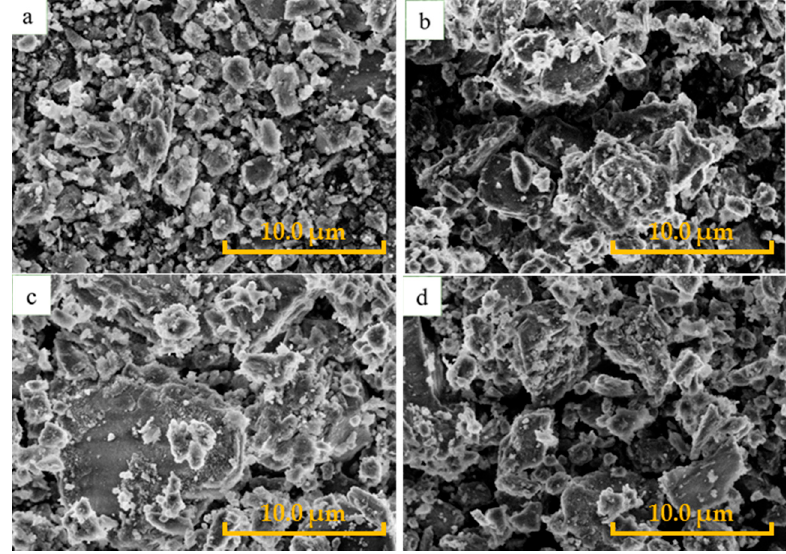
Figure 4. Scanning electron microscope (SEM) image of γ ‐ Al 2 O 3 ( a ); γ ‐ Al 2 O 3 @ASMA ( b ); Pd/ γ ‐ Al 2 O 3 @ASMA ( c ); and modified Pd/ γ ‐ Al 2 O 3 @ASMA ( d ). The scale bar for all images is 10.0 μ m.